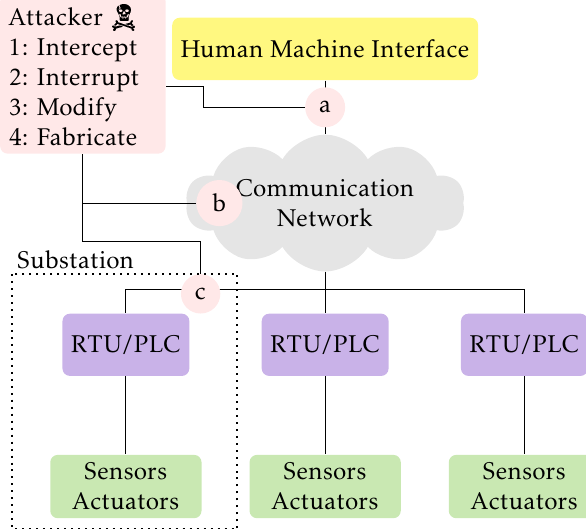
Figure 1. Attack model demonstrating four network attacks, denoted as (1–4), against a simplified SCADA architecture with three attack targets (a–c) based on [7].